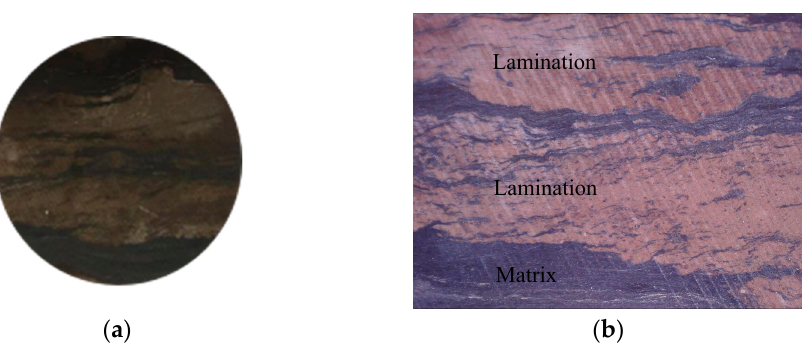
Figure 1. Digital microscope magnifies sample section. ( a ) Sample section. ( b ) Magnified view of sample section.